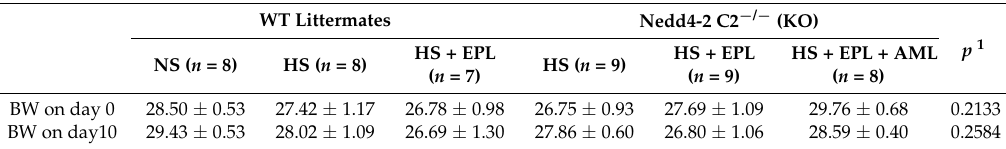
Table 1. Characteristics of body weight (BW) between day 0 and day 10. WT